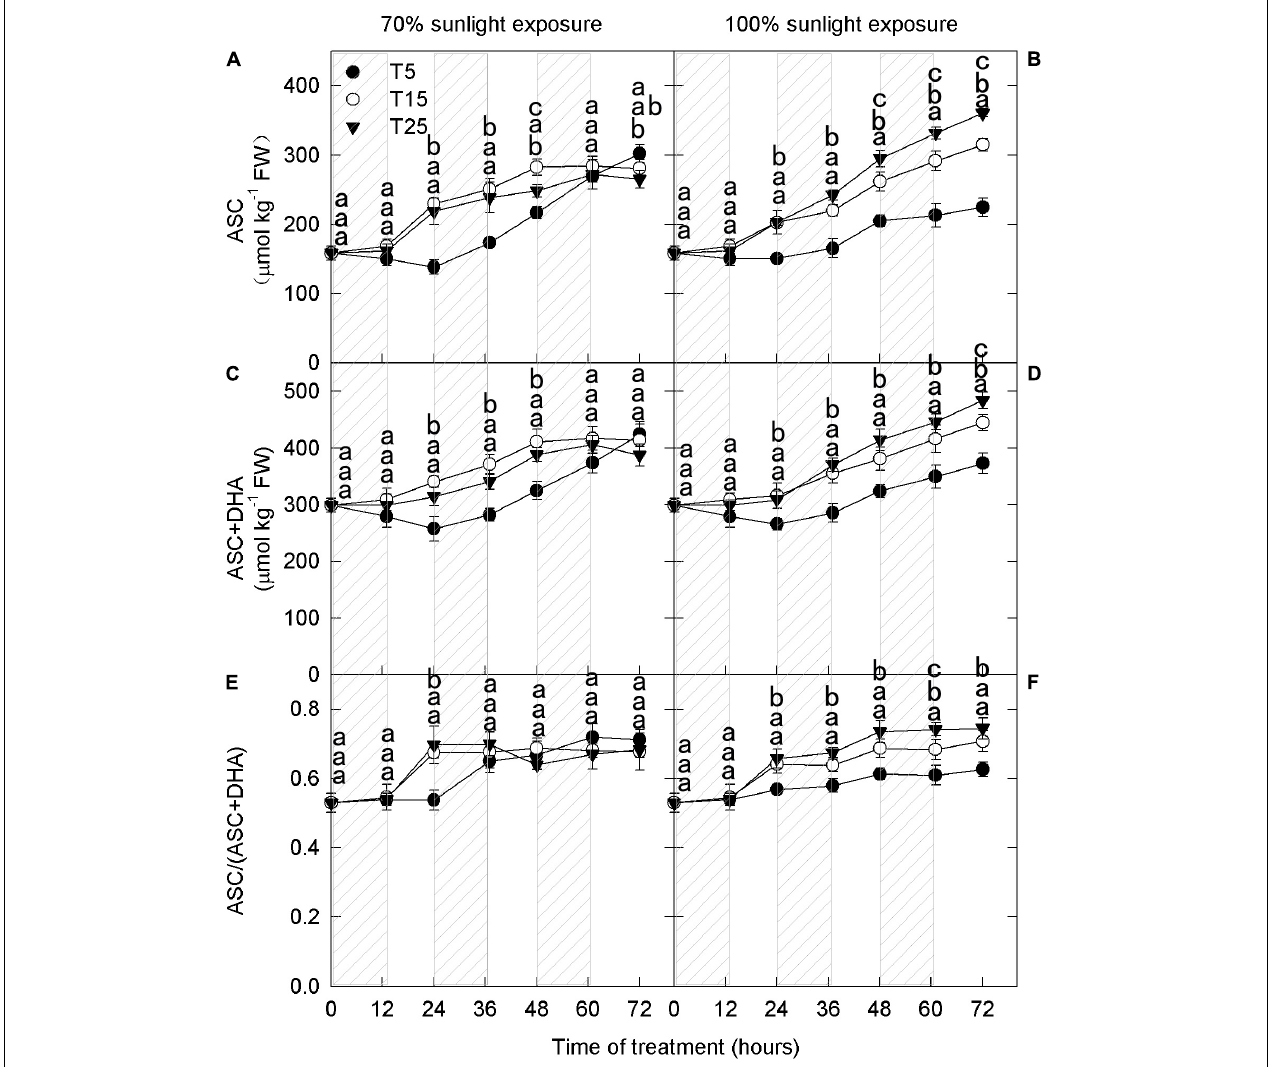
FIGURE 5 | Concentrations of reduced ascorbate and total ascorbate and the ratio of reduced to total ascorbate in the peel of “Fuji” apple fruits exposed to different nighttime temperatures and sunlight intensities. Concentration of reduced ascorbate (A) , total ascorbate (C) , and the ratio of reduced ascorbate to total ascorbate (E) in the peel of “Fuji” apple fruits exposed to nighttime temperatures of 5, 15, and 25 ◦ C and 70% sunlight intensity. Concentration of reduced ascorbate (B) , total ascorbate (D) , and the ratio of reduced ascorbate to total ascorbate (F) in the peel of “Fuji” apple fruits exposed to nighttime temperatures of 5, 15, and 25 ◦ C and 100% sunlight intensity. Different lowercase letters indicate significant difference among treatments at P <